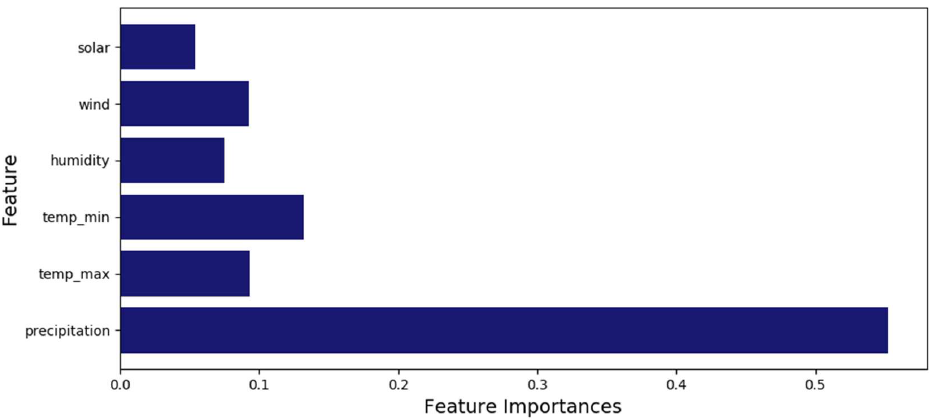
Figure 6. Feature importances in the decision tree model.